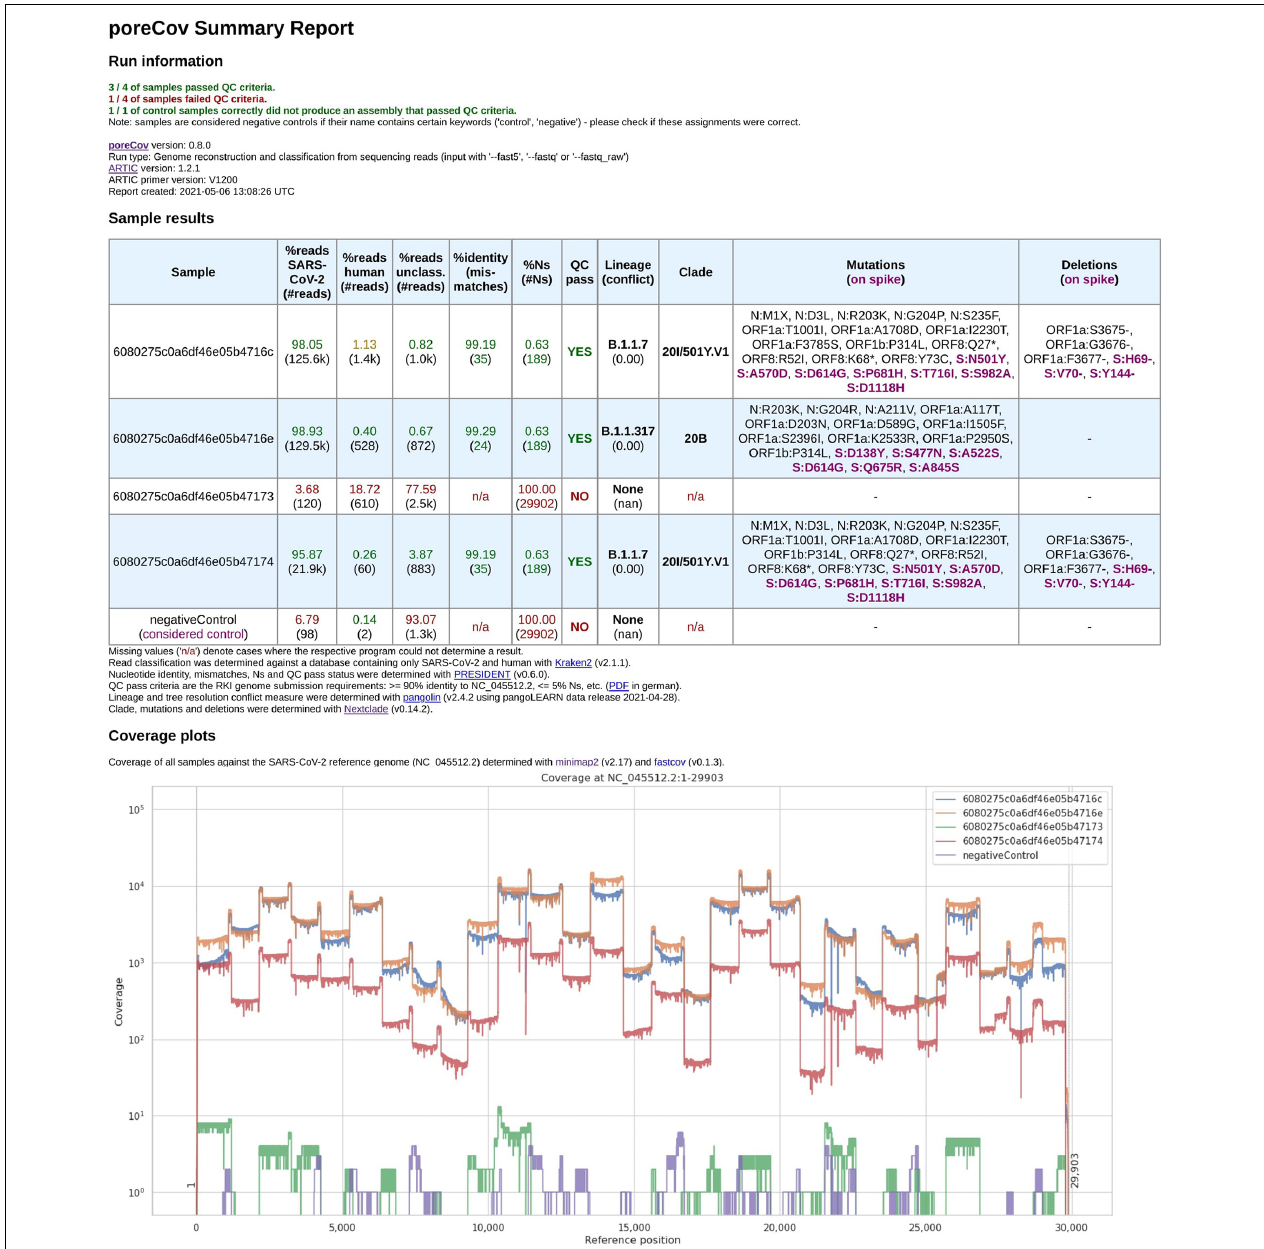
FIGURE 2 | Final report generated by poreCov after each run. Four samples and one negative control were analyzed using 1,200 bp amplicon primers. The first part of the report, the run information, summarizes the overall performance of the sequencing run in a short form across all samples. The second section, the sample results, summarizes all relevant information for each sample in tabular form. The coverage plots are presented in batches of six samples, and additional charts are automatically added for larger runs. The negative control contained 98 reads classified as SARS-CoV-2 which might be attributed to lab contamination or remaining SARS-CoV-2 primers that were